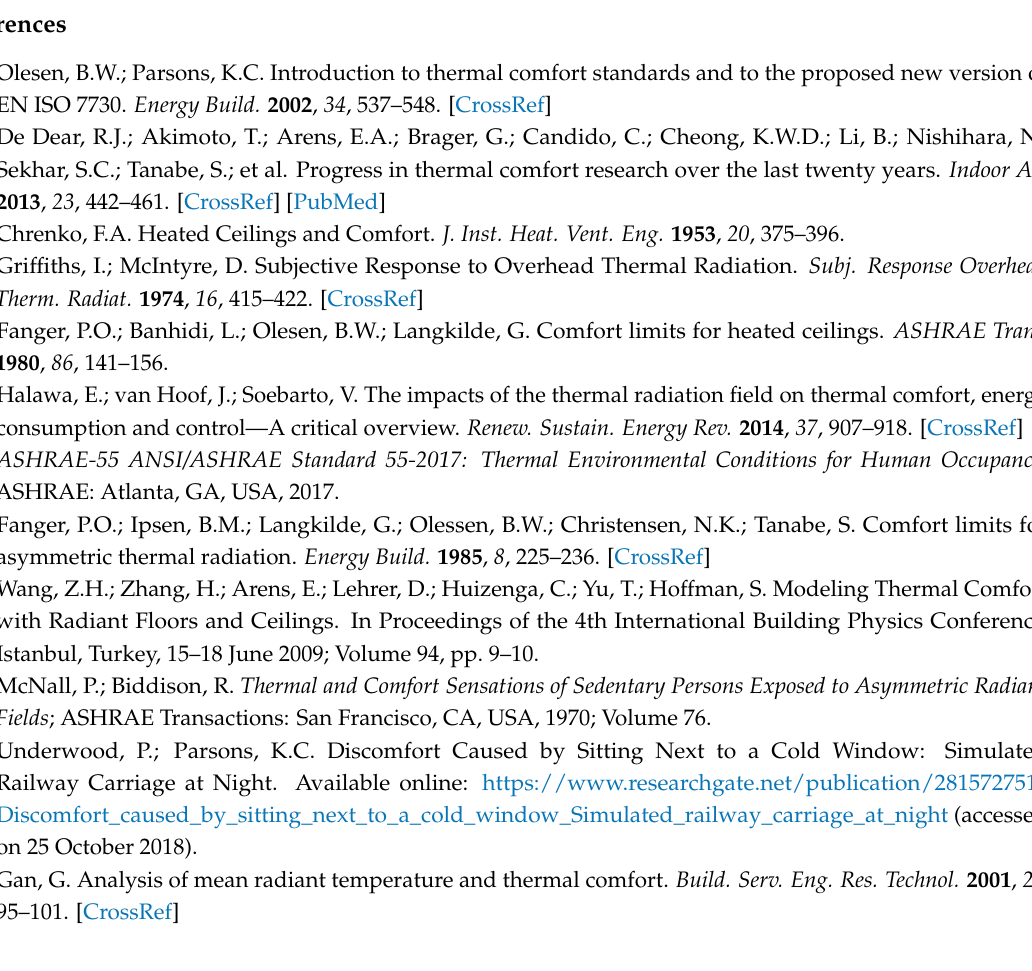
Figure A1. Overall and local thermal sensation votes at 10 body parts corresponding to different ceiling temperatures. TSVs stands for thermal sensation votes.